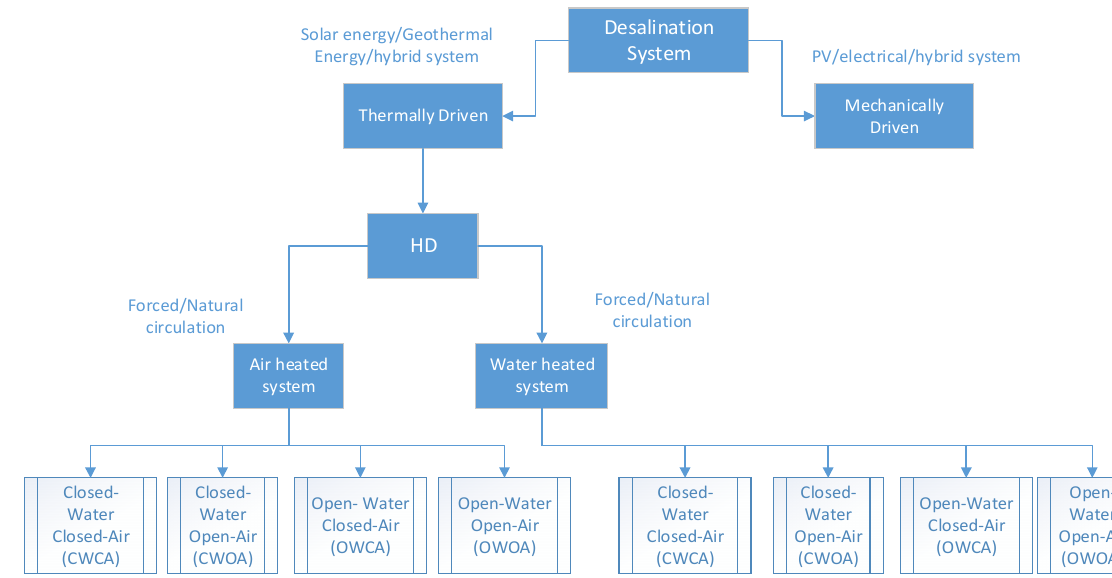
Figure 6. HD system classification based on cycle configurations.